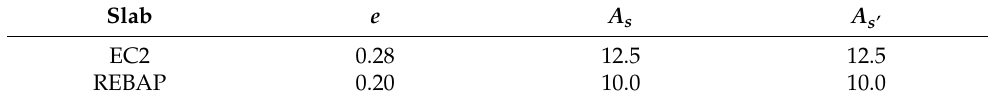
Table 9. Slab dimension for second case of study ( e , As , As’ values in m and cm 2 /m). Slab e